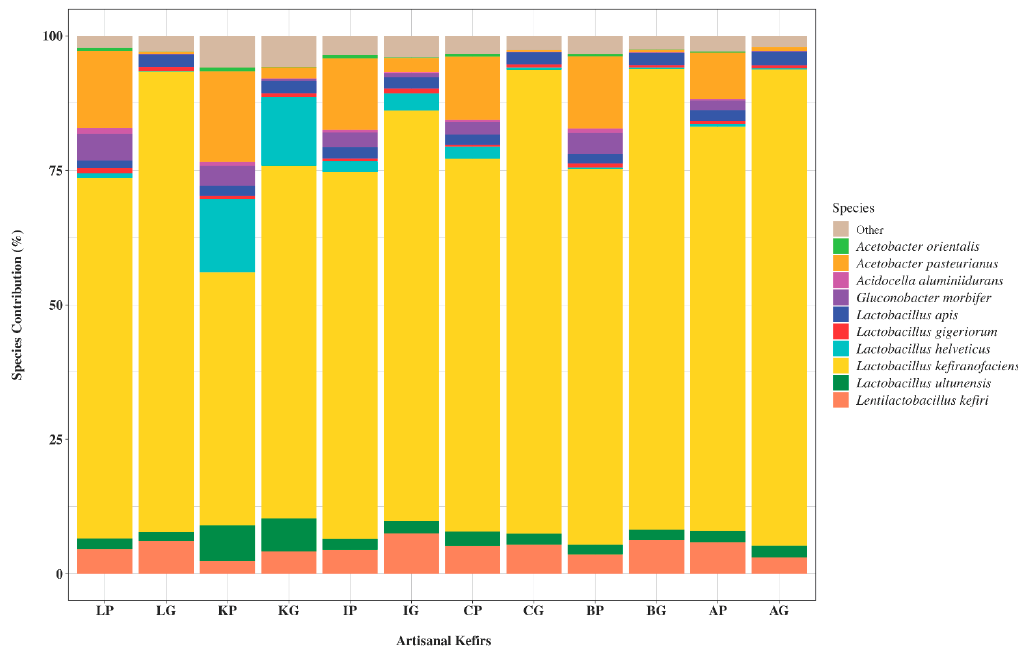
Figure 2. An aggregation of the 10 most abundant bacterial species, using the calculated relative abundance and scaling (0–100) species contribution. Kefir product from Lithuania (LP), kefir grains from Lithuania (LG), kefir product from South Korea (KP), kefir grains from South Korea (KG), kefir product from Ireland (IP), kefir grains from Ireland (IG), kefir product from the Caucuses region (CP), kefir grains from the Caucuses region (CG), kefir product from Britain (BP), kefir grains from Britain (BG), kefir product from Fusion Tea (AP, Amazon), kefir grains from Fusion Tea (AG, Amazon). Differences exist in artisanal kefirs regarding microorganisms present in kefir products versus their grains. For example, L. kefiranofaciens exhibits a higher relative abundance in all kefir grains when compared to their corresponding products (Figure 2). Similarly, Lent. kefiri exhibits a higher relative abundance in kefir grains B, I, K, and L when compared to their corresponding products